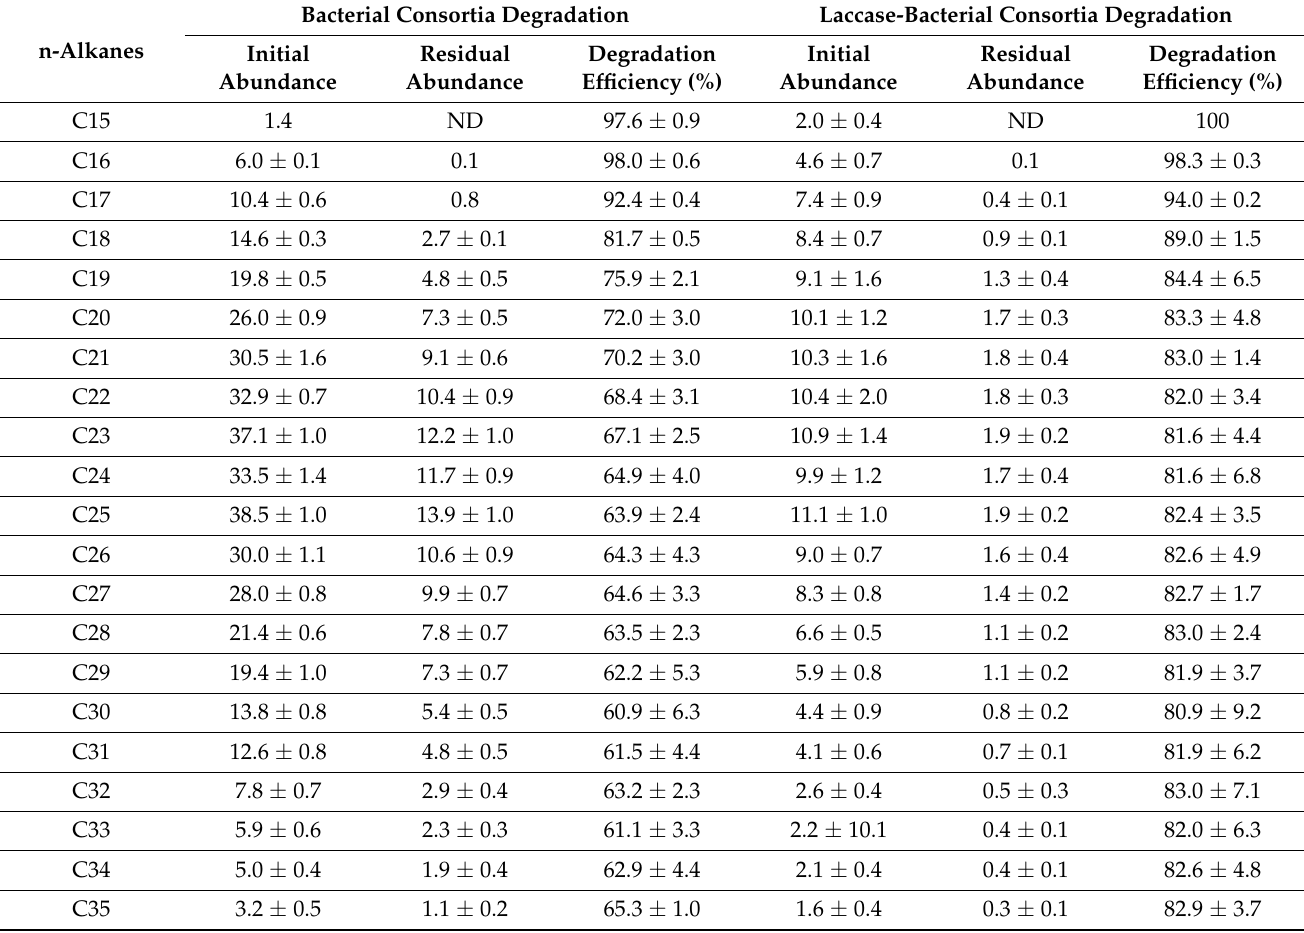
Table 1. Degradation efficiencies of the bacterial consortia and laccase-bacterial consortia for C15 to C35 n-alkanes. Bacterial Consortia Degradation Laccase-Bacterial Consortia n-Alkanes